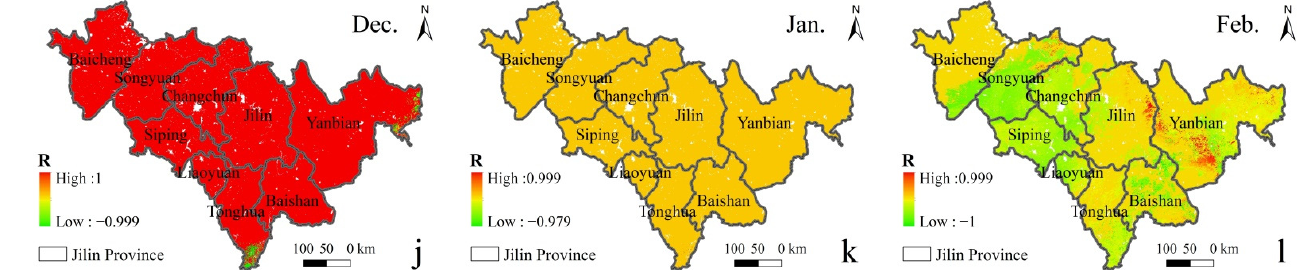
Figure 7. Spatial distribution of the correlation between GPP and ρ (SO 2 ) in different months in Spring, Summer and Autumn of 2015–2020. (( a ). Mar., ( b ). Apr., ( c ). May., ( d ). Jun., ( e ). Jul., ( f ). Aug., ( g ). Sept., ( h ). Oct., ( i ). Nov., (j). Dec., (k). Jan., ( l ). Feb.).